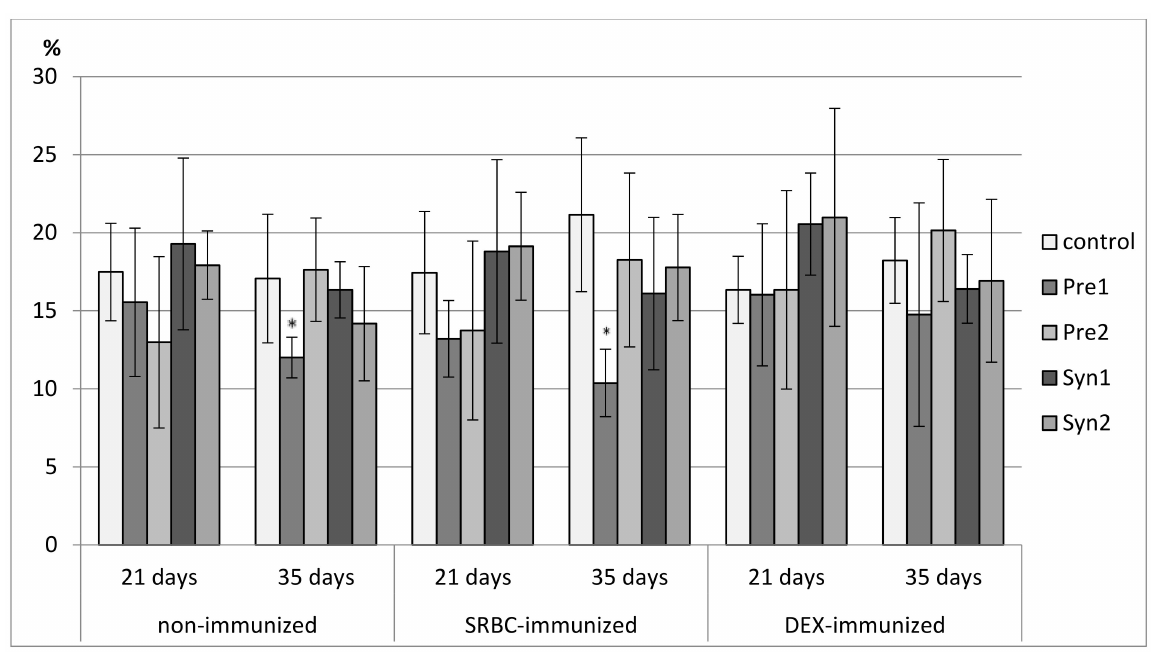
Figure 4. The percentage of CD4 − CD8 − cells in the thymus of chicken broilers after in ovo injection of the investigated prebiotics or synbiotics. The data are expressed as the mean ± SD. Data with a symbol (*) denote a significant difference with respect to the control group ( p < 0.05).